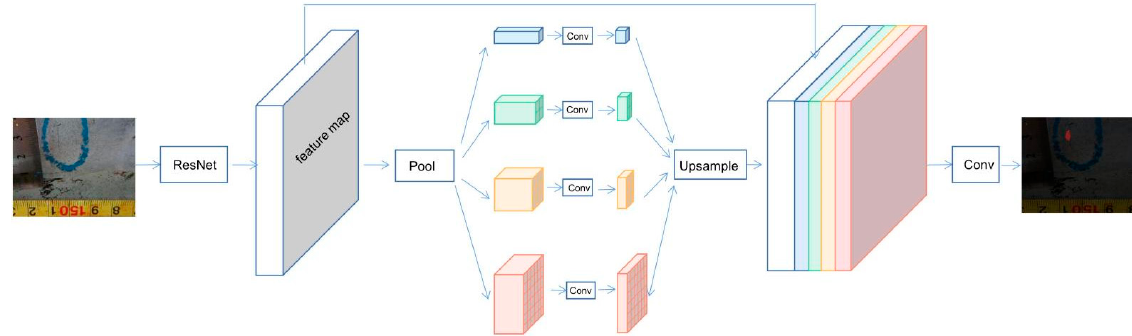
Figure 5. Structure diagram of PSPNet.